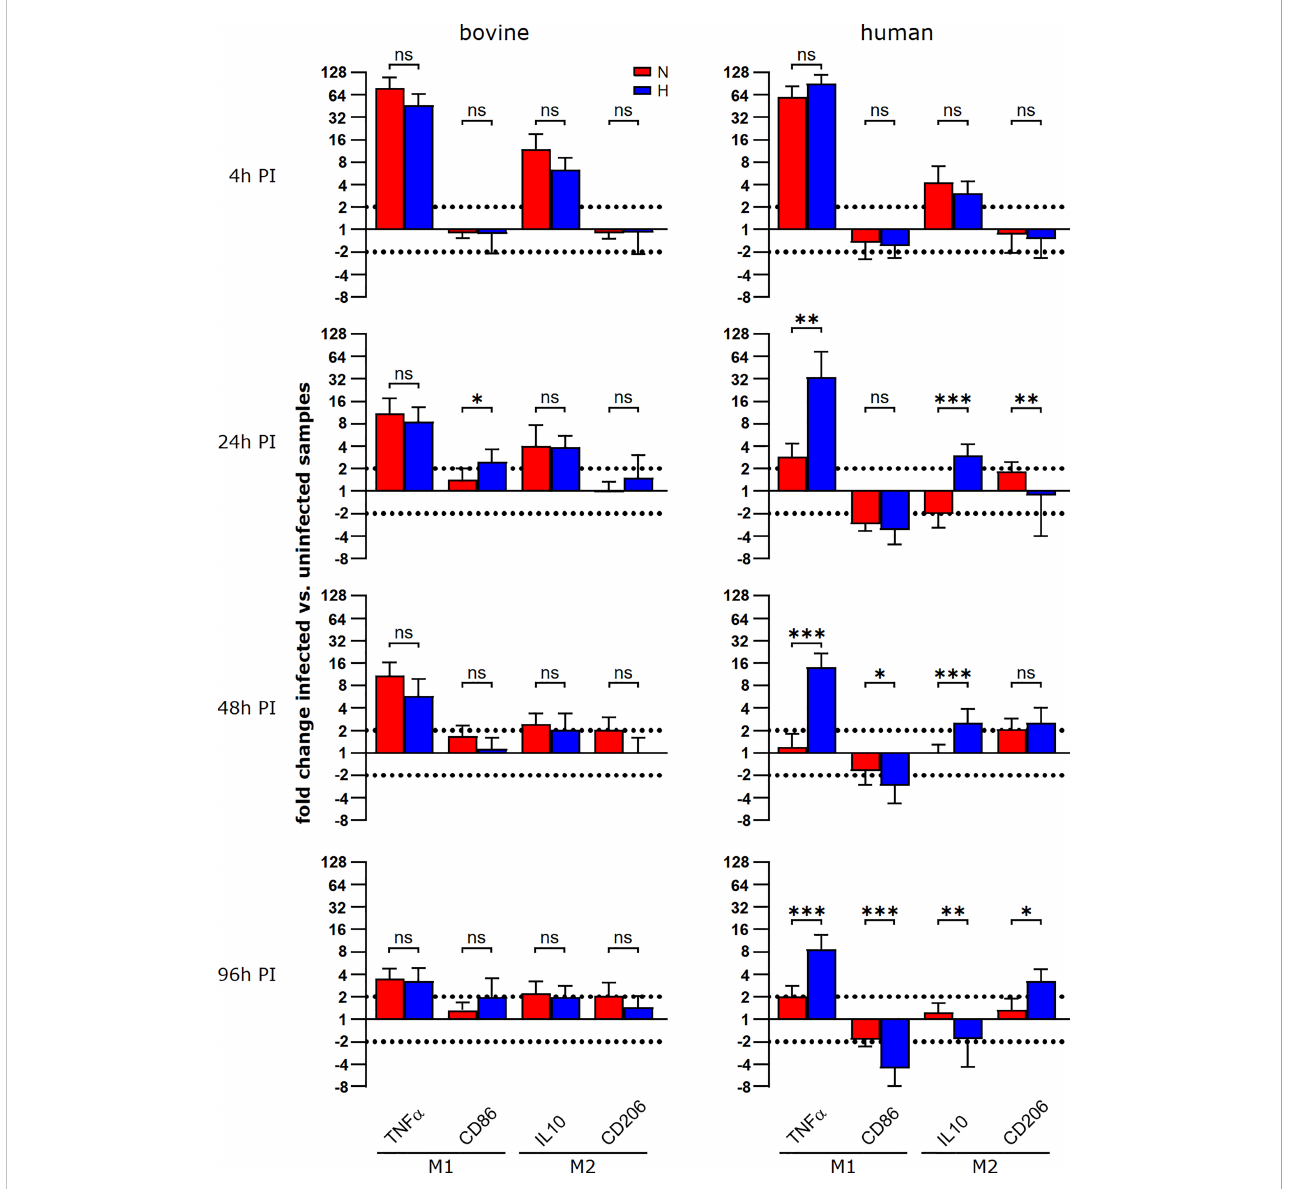
FIGURE 8 During the course of a C. burnetii infection, TNF a expression is only maintained in hypoxic human macrophages. Gene expression was determined for M1/M2 polarization marker genes in C. burnetii NMII infected human or bovine macrophages at the time points indicated. Data are shown as mean ± SD of DD CT values (using uninfected samples as a calibrator), Mann-Whitney test, n=5-8 (bovine) and n=6-10 (human) ***p<0.001, **p<0.01, *p<0.05,